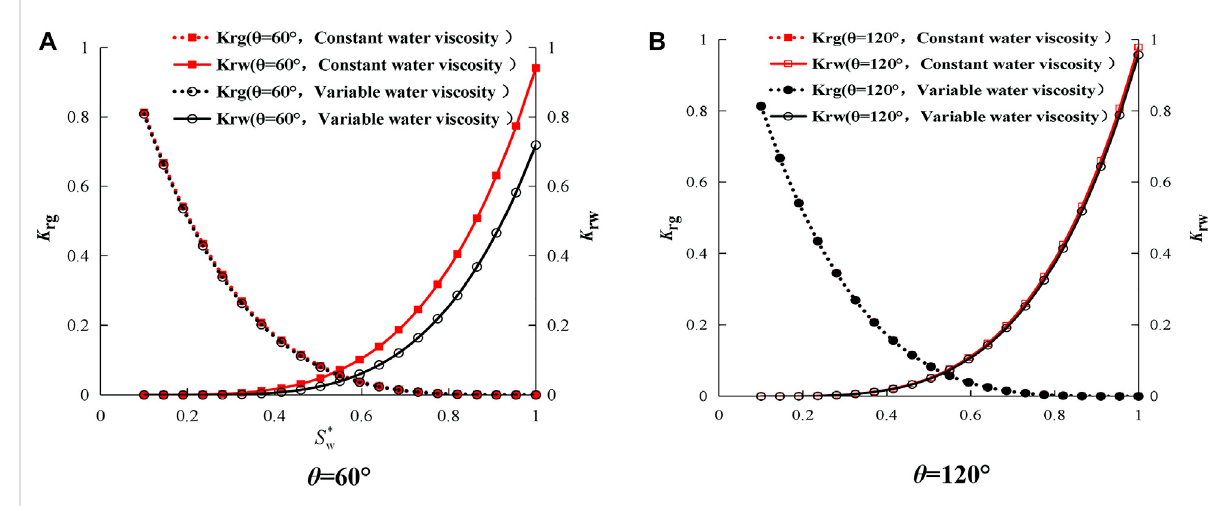
Effect of variable water phase viscosity on the two-phase relative permeability in porous